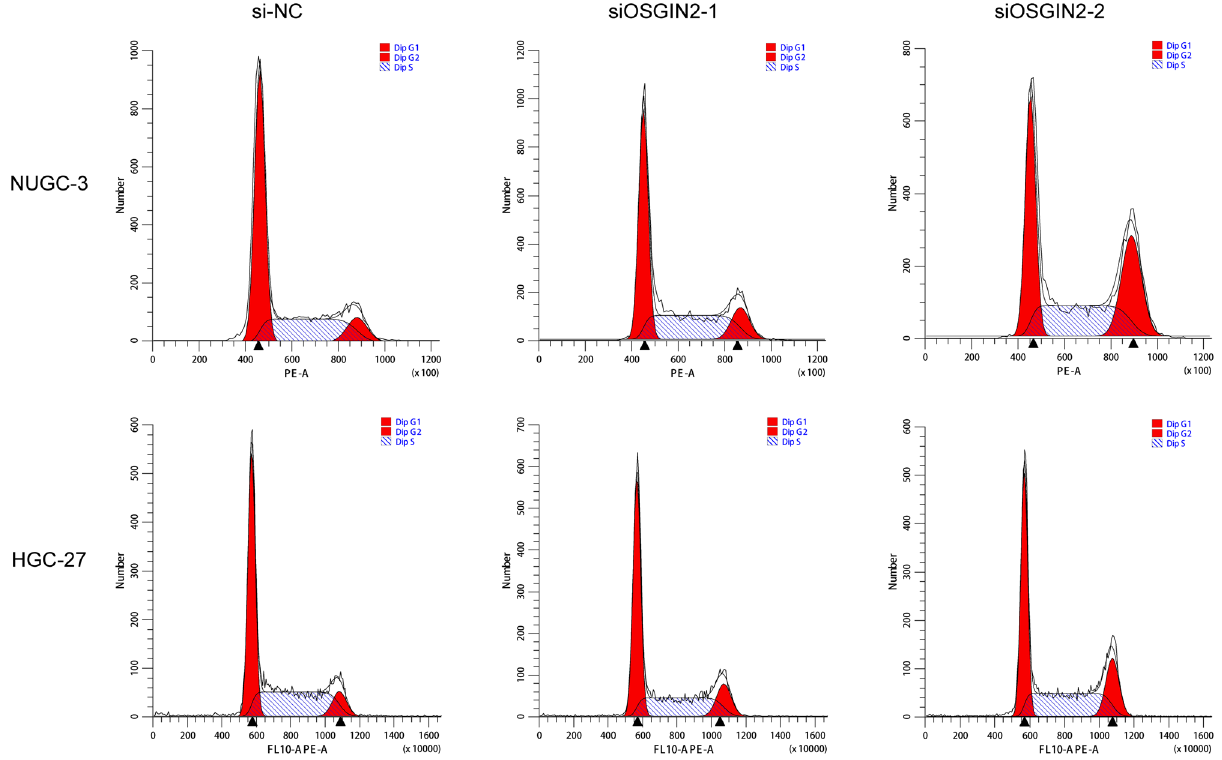
Figure 8. The role of OSGIN2 on cell cycle regulation Cell cycle of OSGIN2-knockdown NUGC3 and HGC27 cells. (n =